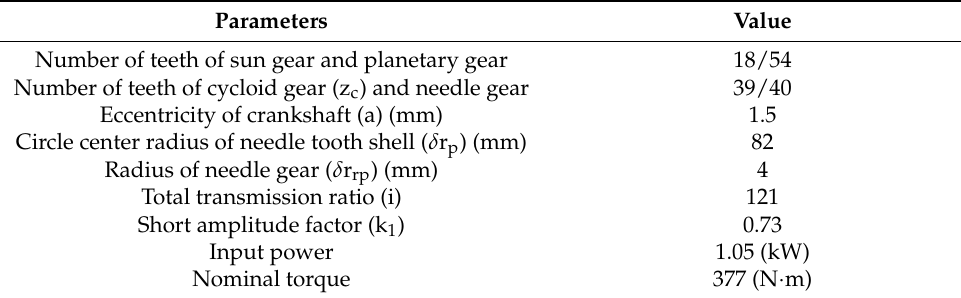
Table 1. The main parameter of RV-40E reducer.